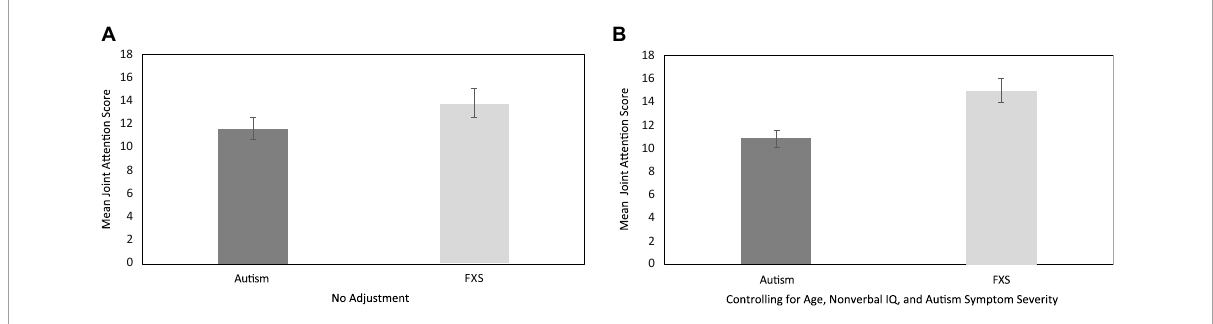
FIGURE1 Between-group descriptive comparisons of total joint attention performance, with no adjustment (A) and after controlling for the effects of age, non-verbal IQ and autism symptom severity (B) .